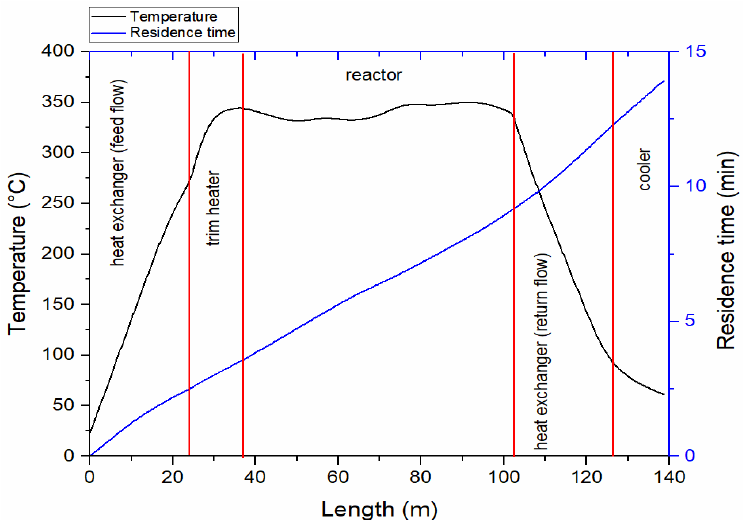
Figure 3. Temperature profiles and residence time distribution in the different HTL process units (heat exchanger-feed flow, trim heater, reactor, heat exchanger-return flow and cooler) at 220 bar for HTL of Miscanthus .